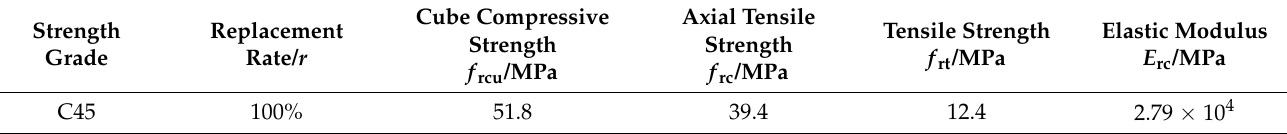
Table 3. Basic mechanical properties of recycled